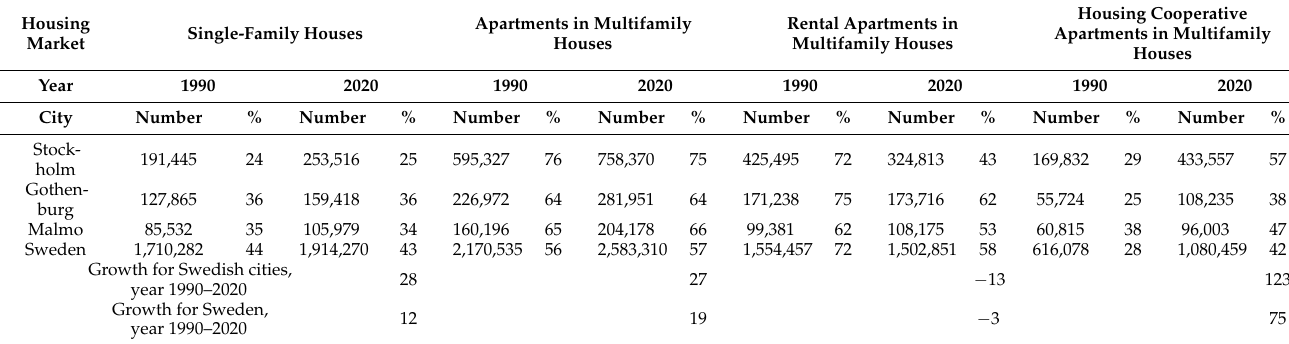
Table 2. The housing stock in Sweden, year